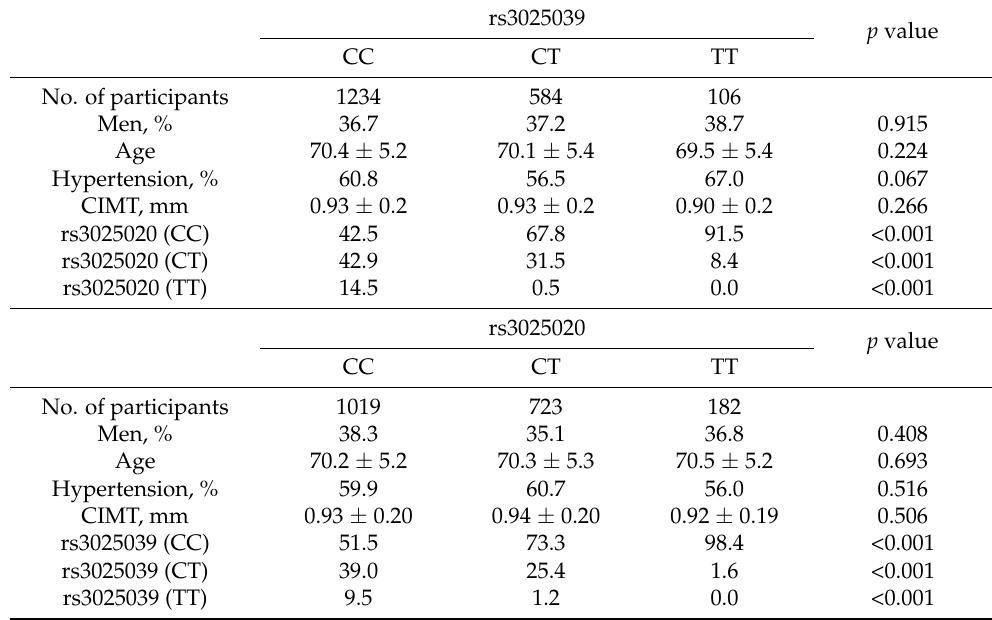
Table 1. Characteristics of the study population by rs3025039 or rs3025020 genotype.